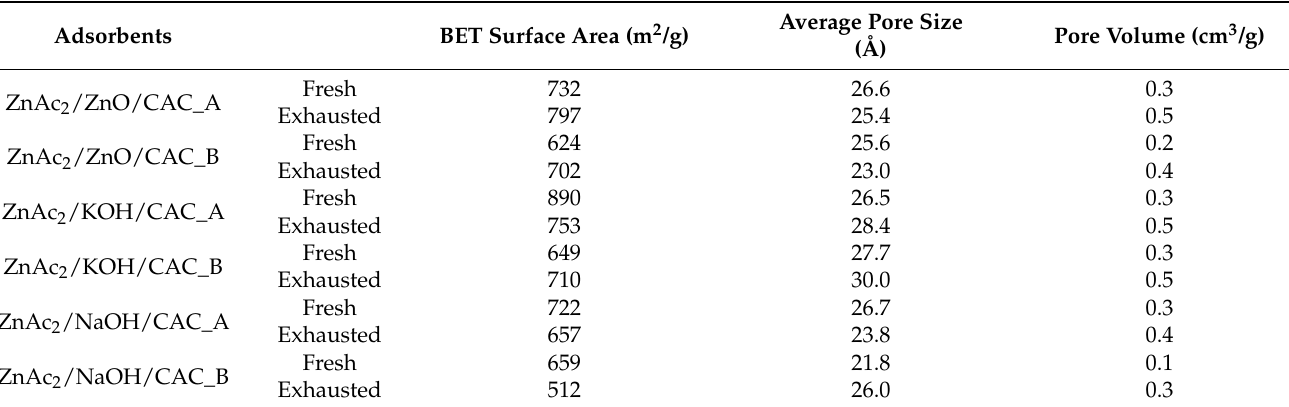
Figure 2. Nitrogen adsorption isotherms for modified porous adsorbents. Table 2. Porous properties of fresh and exhausted